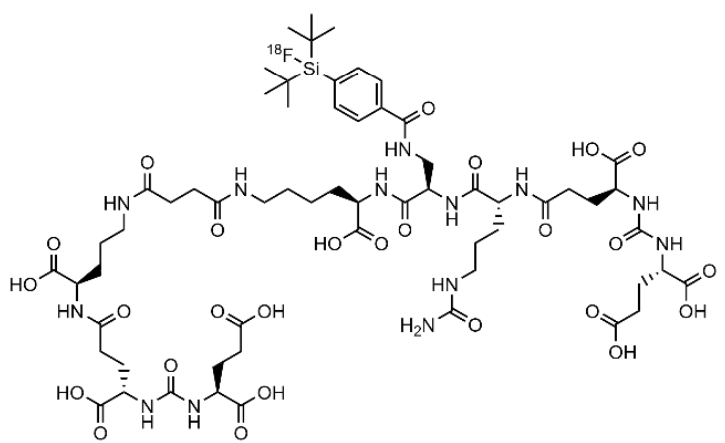
Figure 1. Chemical structure of the PSMA-specific radioligand [ 18 F]F-siPSMA-14.